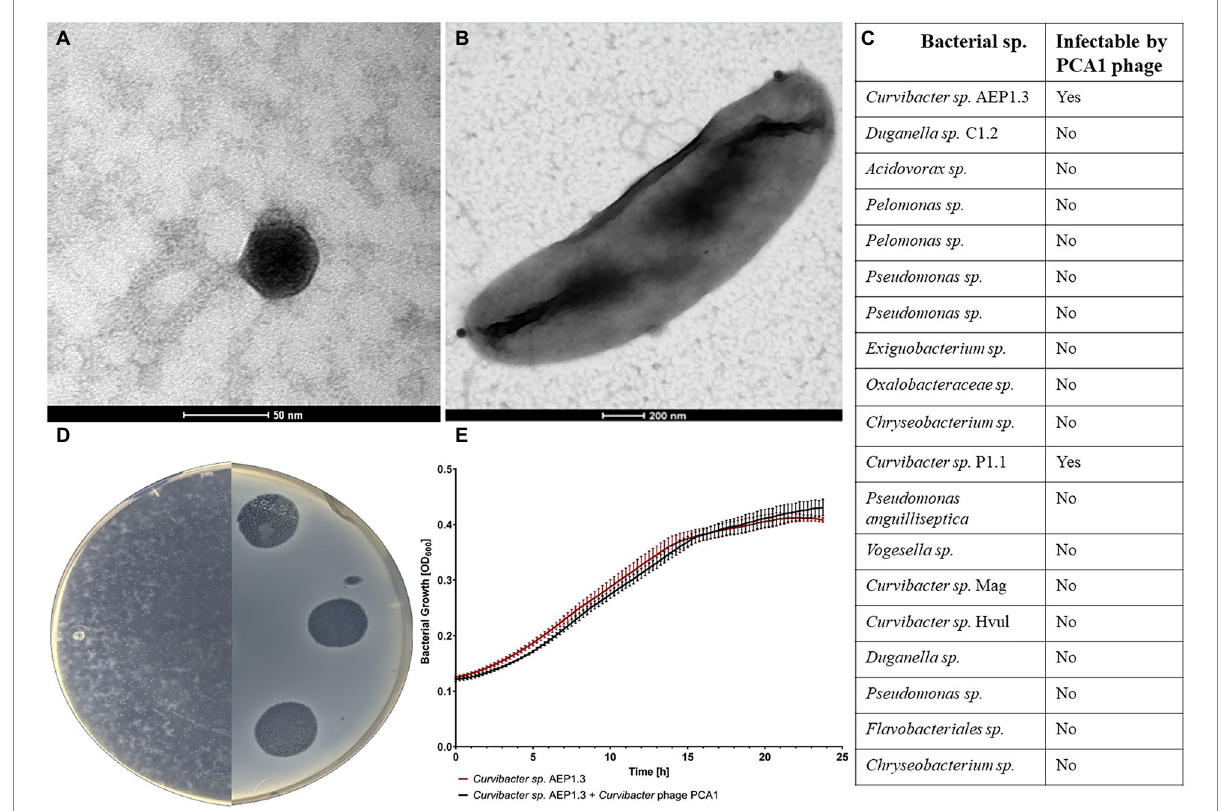
FIGURE 1 (A) TEM image of Curvibacter phage PCA1 stained with uranyl acetate. (B) TEM image of Curvibacter sp. AEP1.3 cell infected with Curvibacter phage PCA1. (C) Table depicting host range of Curvibacter phage PCA1 with bacterial strains in the first column and ability to infect in the second. (D) Image of R2A agar plates containing a bacterial lawn of Curvibacter sp. AEP1.3 infected with Curvibacter phage PCA1. (E) Bacterial growth of Curvibacter sp. AEP1.3, with and without PCA1 phage, in liquid R2A medium. Recorded via Optical Density measurements at 600 nm for 24 h ( n =